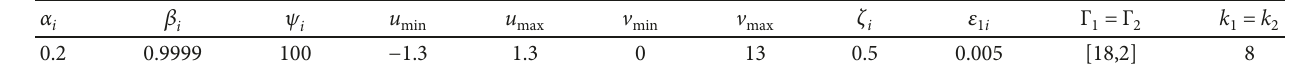
Table 1: Control parameters of the vehicles ( i = 1, 2, … , 7